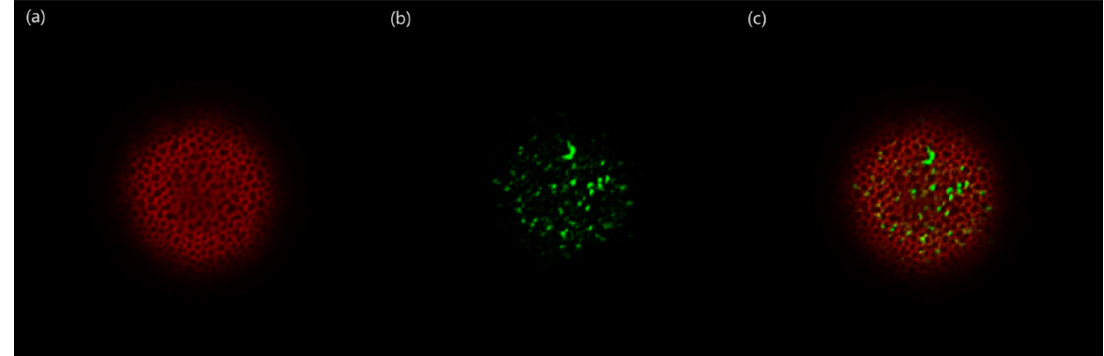
Figure 13. Confocal microscopic images showing the distributions of ( a ) nile red, ( b ) FITC-dextran, and ( c ) nile red and FITC-dextran within PLGA microspheres.